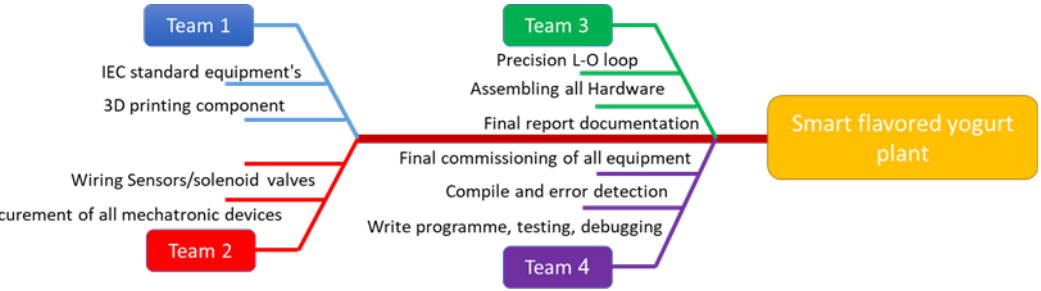
Figure 4. Course design based on project management methodology.